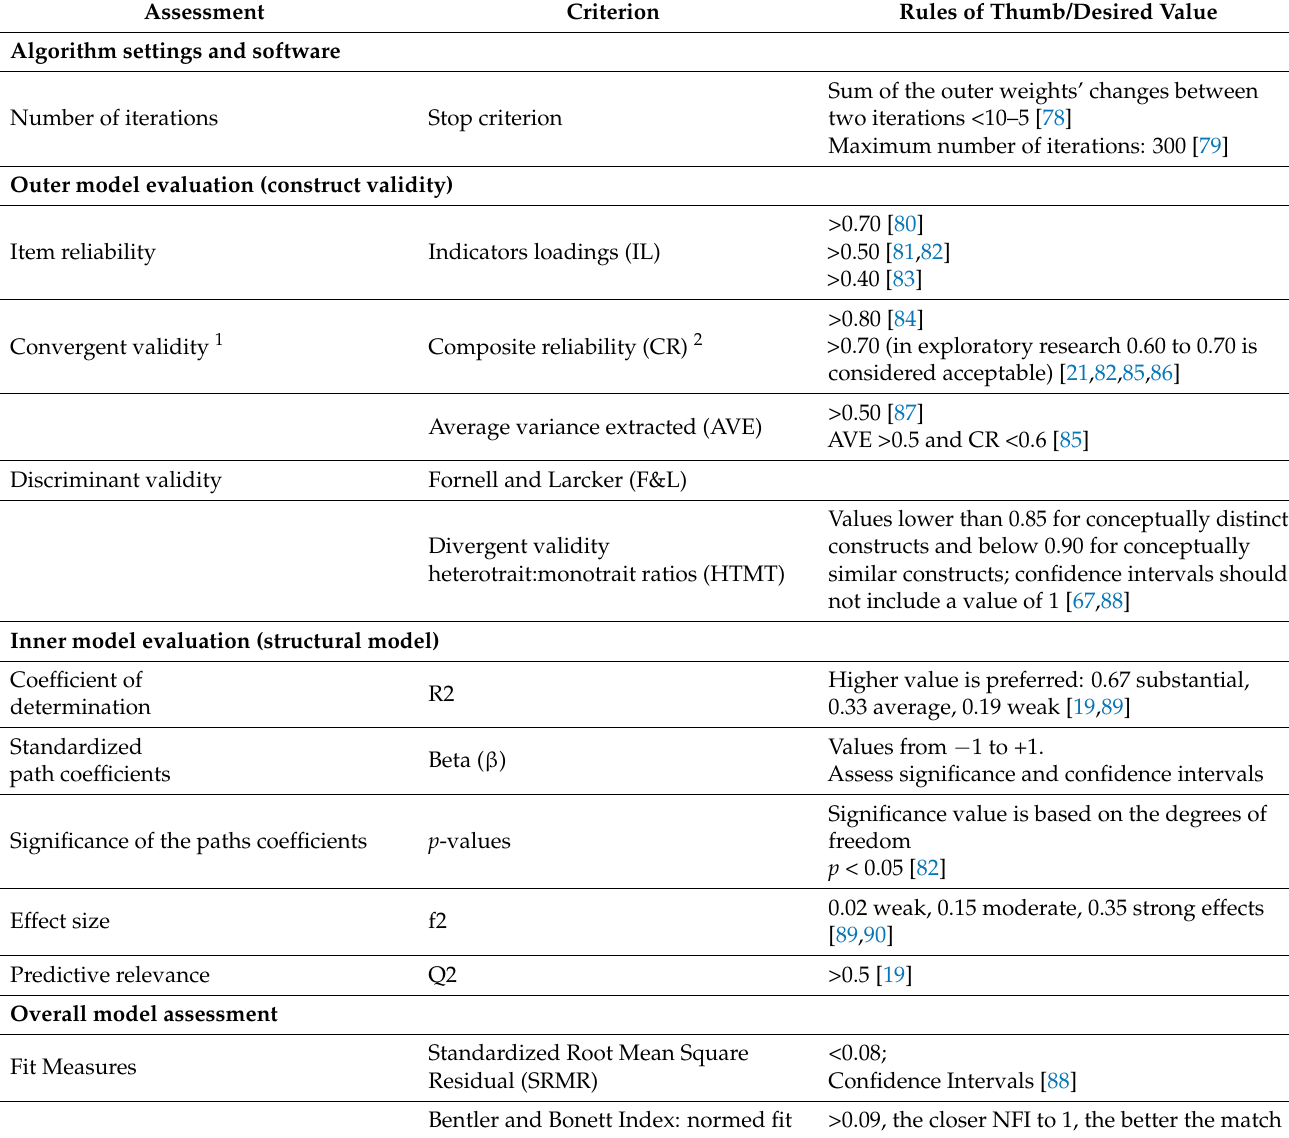
Table 2. Recommended assessment of